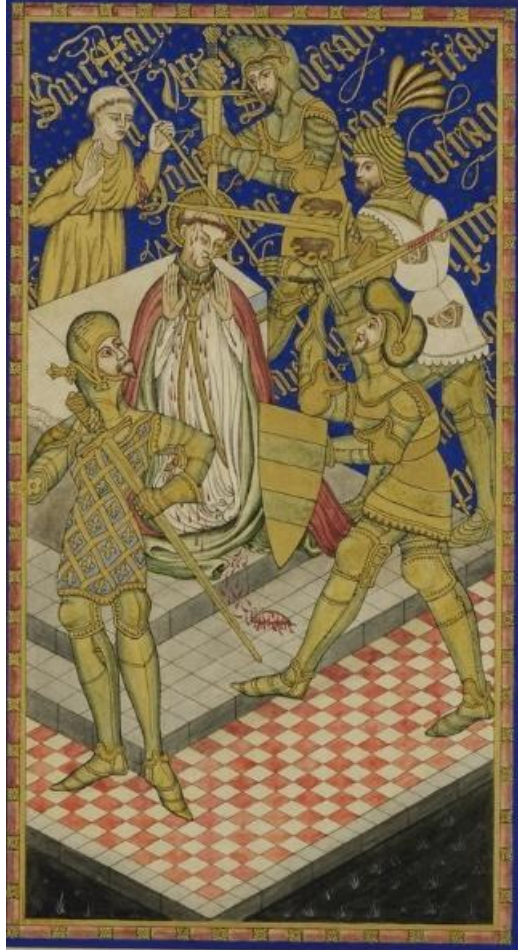
Figure 13. The martyrdom of Thomas Becket, from the tester of the tomb of Henry IV,